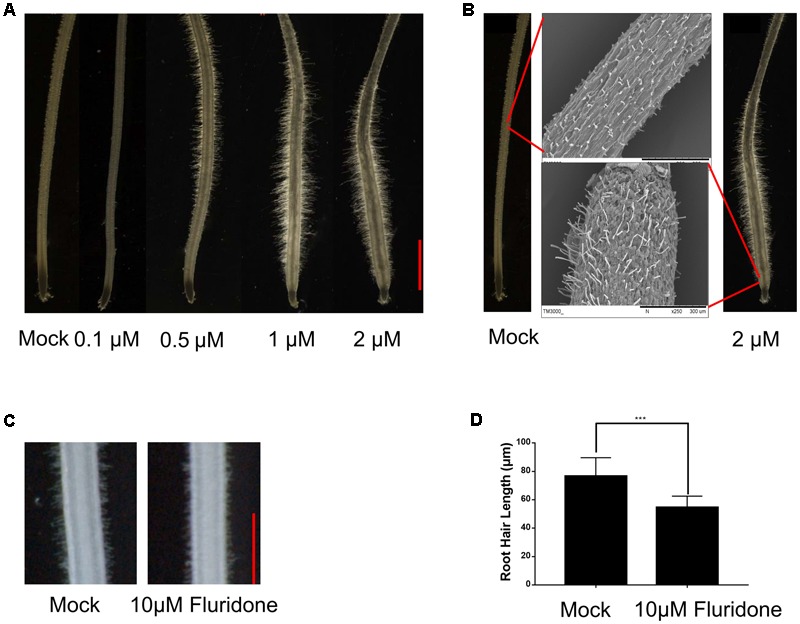
ABA promotes root hair elongation in the rice root tips. (A) The 5-day-old rice root tips grown in solution containing the indicated concentrations of ABA for 24 h. Scale bar = 1 mm. (B) Morphology of root hair initiation zones in the 6-day-old crown roots treated with mock or 2 μM ABA for 24 h. (C) Root hair morphology of the wild type with or without Fluridon (10 μM) treatment. Scale bar = 500 μm. (D) Quantification of root hair length of the wild type with or without Fluridon treatment. Data are means ± SD.